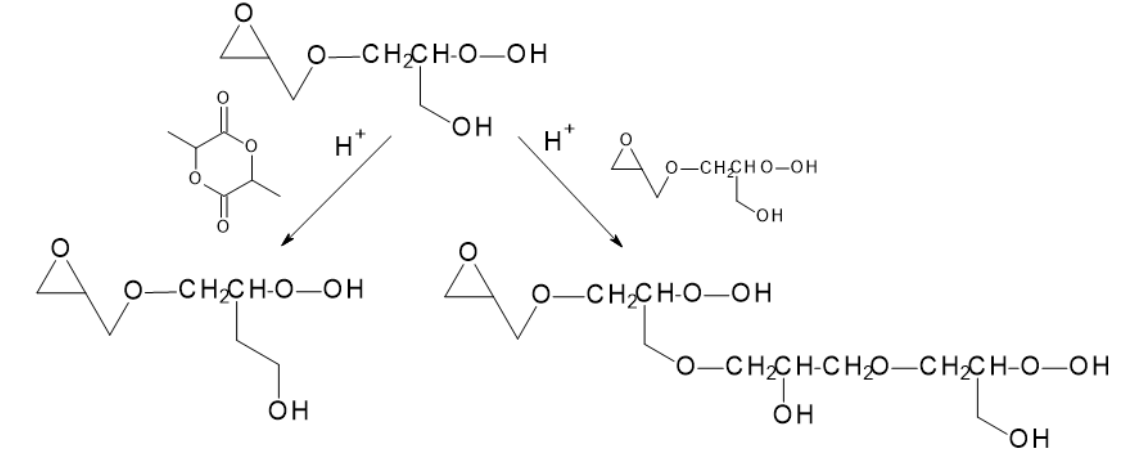
Figure 23. Mechanism of branched polymer formation by ring-opening copolymerization of lactide with glycidol [84].